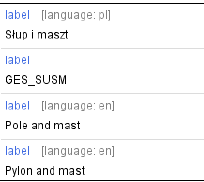
Figure 2. OWL Class